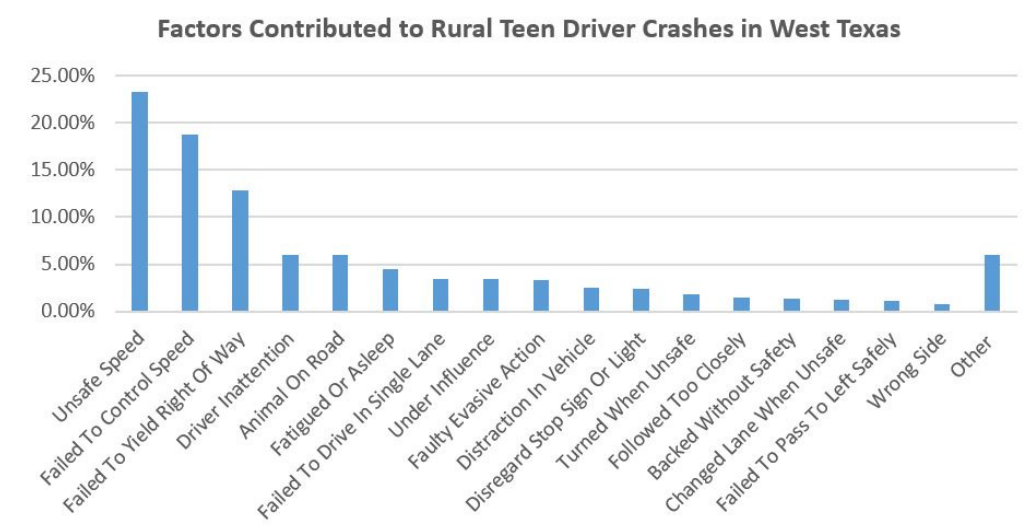
Figure 2. Major contributing factors to teen driver crashes in West Texas rural areas.